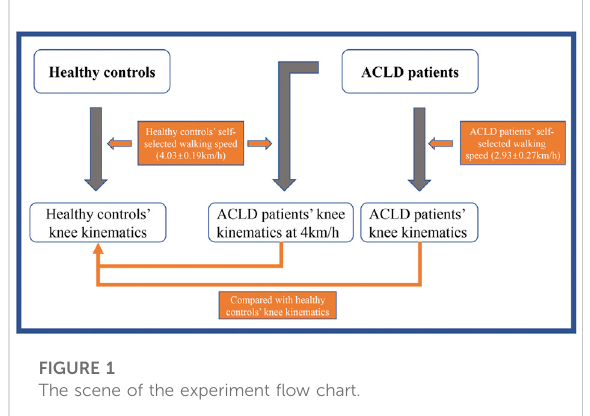
FIGURE 1 The scene of the experiment fl ow